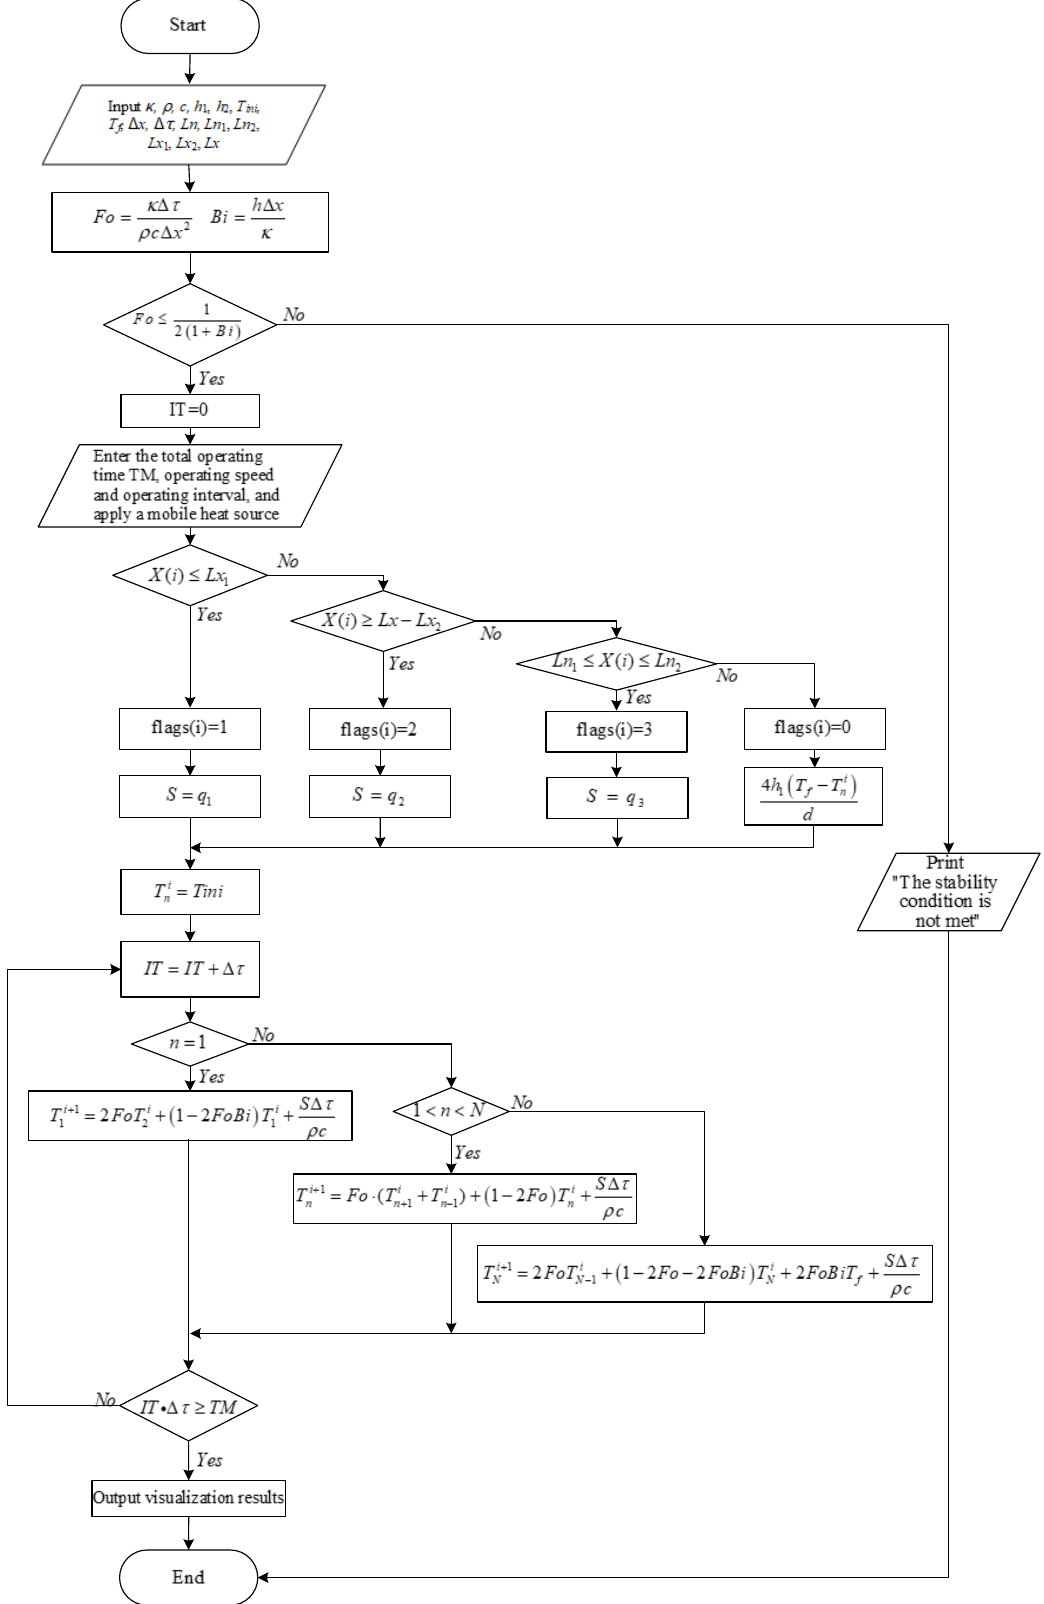
Figure 8. The finite difference method to solve the temperature distribution flow chart of the ball screw feed